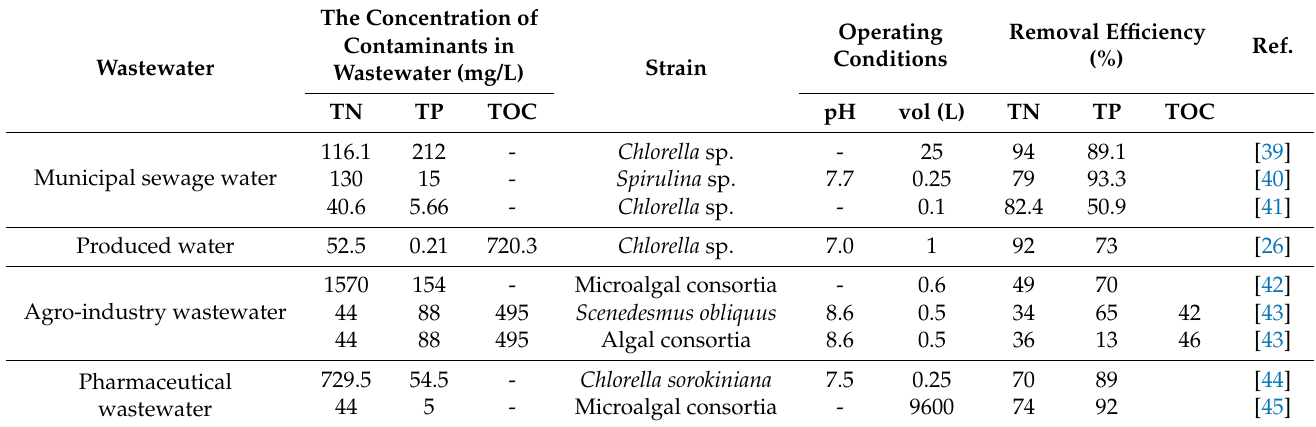
Table 1. Microalgal nutrient removal efficiencies from different